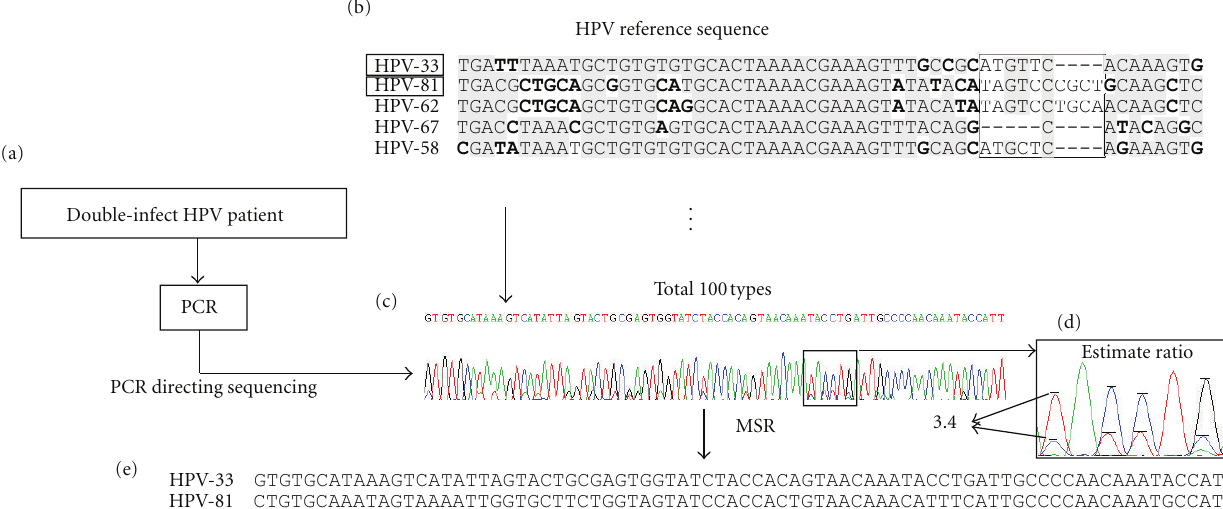
Figure 4: Application of MSR in identifying double-infection of HPV in a cervical cancer sample. (a) A sample infected with two strains of HPV was selected according to HPV array results. The HPV sequences in the specimen were amplified with a pair of PCR primers specific to the L1 region. (b) Alignment of the L1 sequences of several HPV genotypes. (c) PCR direct sequencing results showed a mixed chroma- tography trace representing two HPV genotypes. (d) MSR estimated the LRi ratio between the major/minor sequences. (e) The MSR output showed that the sample was infected with HPV genotypes 33 and 81.